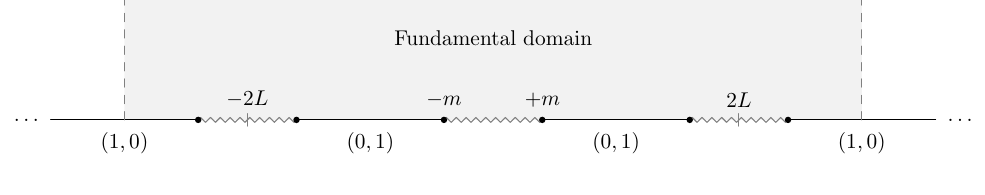
Figure 7 . Rod structure for Example